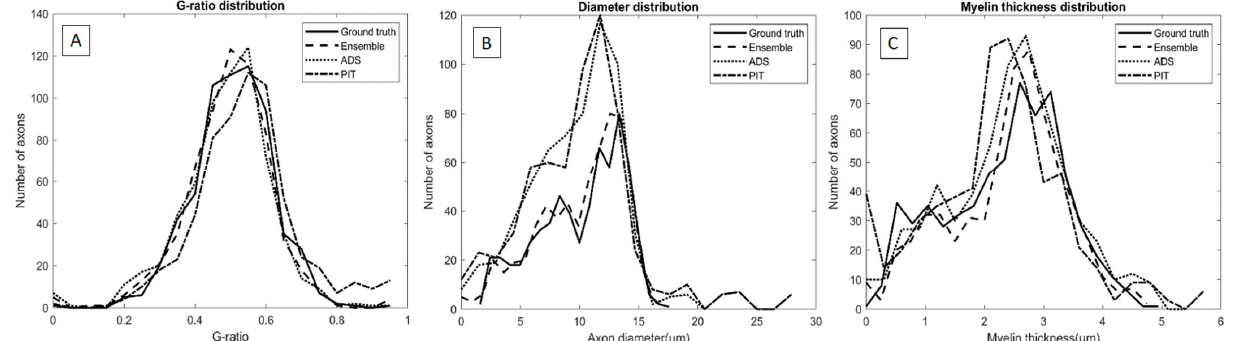
Figure 6 . Curve histograms of the morphological data. ( A ) the G ‐ ratios, ( B ) axon diameters, and ( C ) myelin thicknesses. The plots contain the measurements that are based on the ground truth testing images, ensemble, ADS, and PIT segmented images.